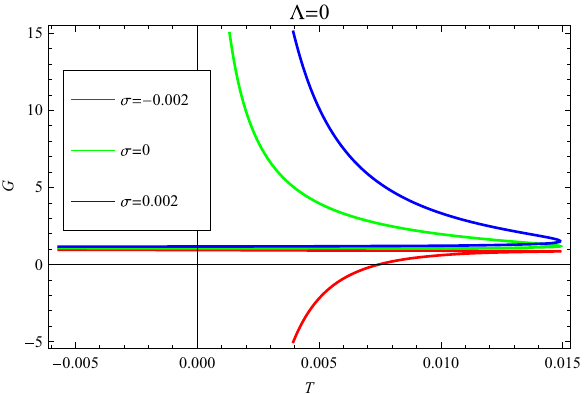
Fig. 3 Plot of Gibbs free energy versus temperature in the presence of surface tension for second case when the cosmological constant is zero and Q m = 2 of the non-minimal MCRBH